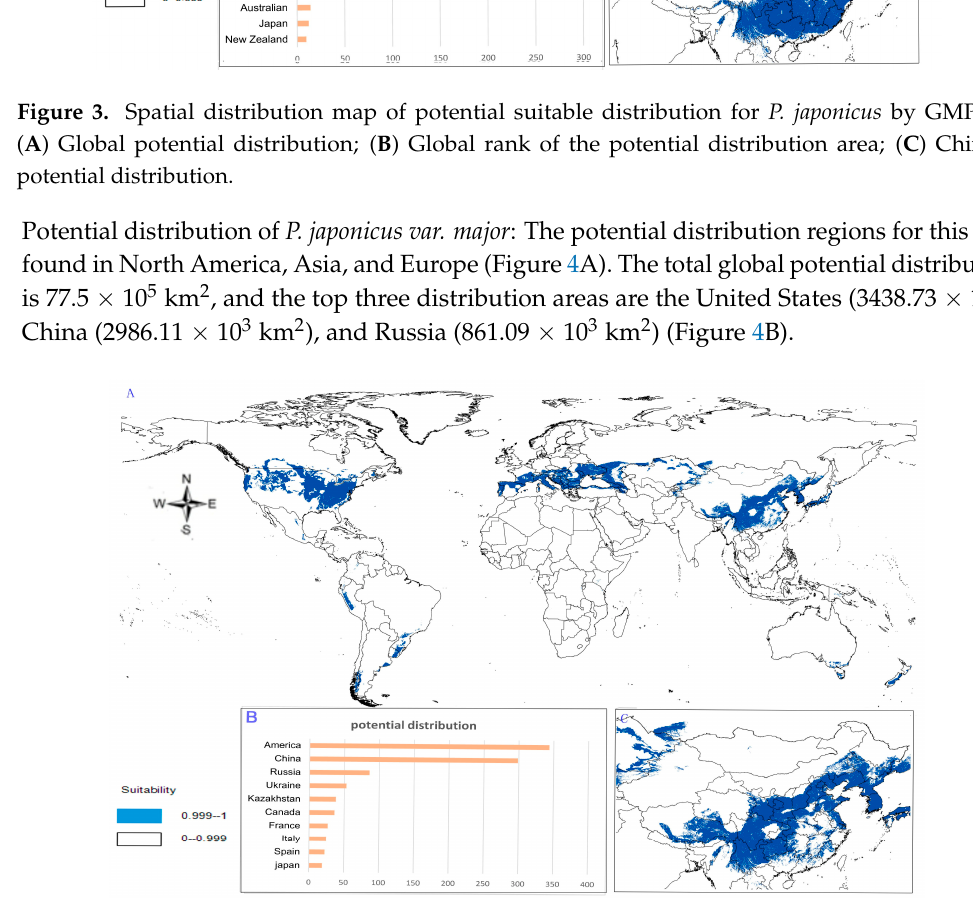
Figure 4. Spatial distribution map of potential suitable distribution for P. japonicus var. major by GMPGIS. ( A ) Global potential distribution; ( B ) Global rank of the potential distribution area; ( C ) Chinese potential distribution.